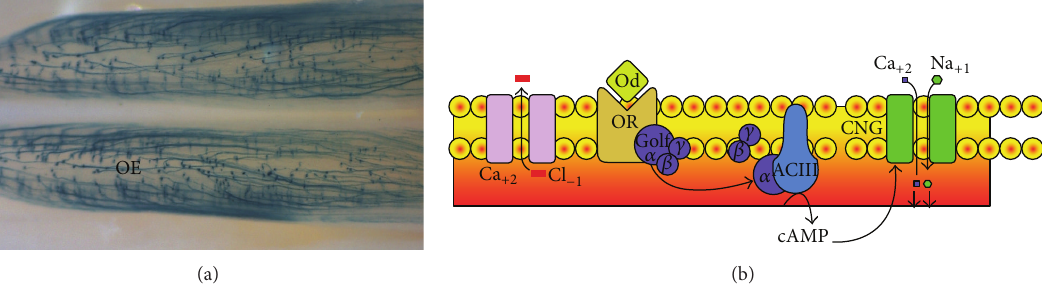
Figure 3: OSNs in the OE and OR signaling pathways. (a) The OSN somas and cilia (dots), where the OR signaling pathways occur, transduce the information to the axons (lines) through action potentials that eventually reach the OB. (b) Diagram of the signaling pathway of a standard OR after activation. The interaction of odorants with their receptors on the OSN cilia and soma leads to Golf activation, which activates ACIII, thus causing increased cAMP levels. Next, cAMP activates CNG channels that allow the entry of sodium and calcium. Finally, this latter ion activates a chloride channel that contributes to depolarization enough to reach the threshold for action potentials. Modified from